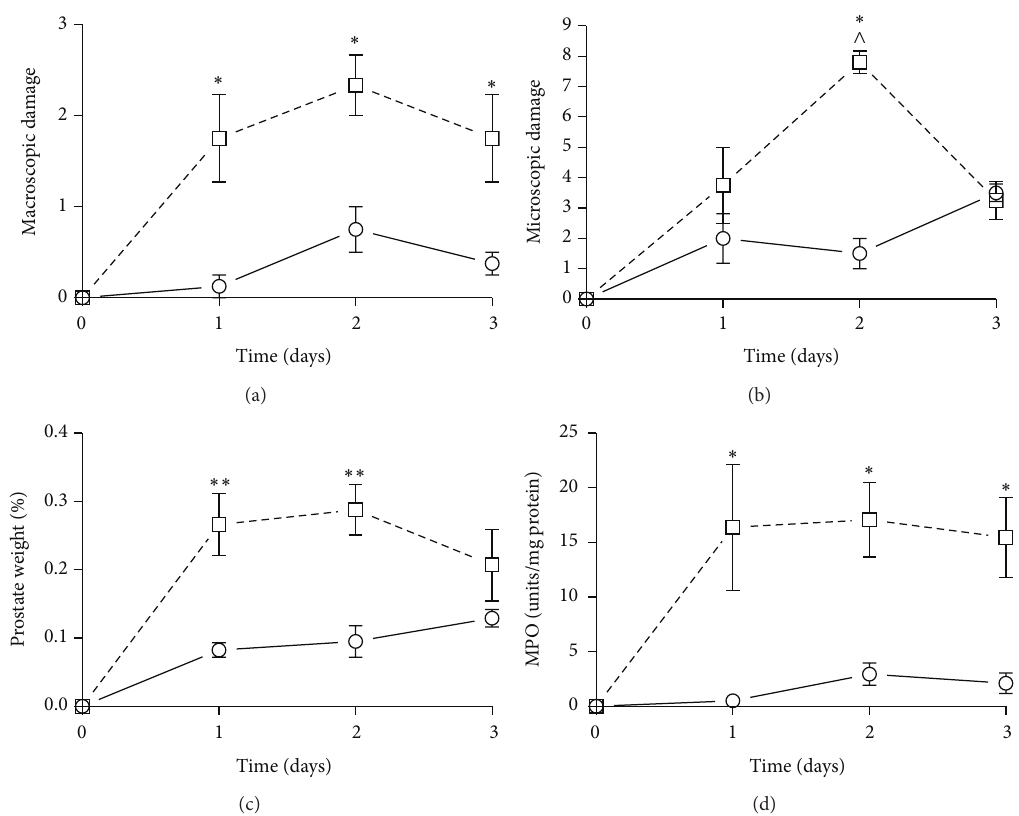
Figure 1: Ethanol + dinitrobenzene sulfonic acid induces inflammatory changes in wild-type mice 2 days posttreatment. Prostates were treated with sterile saline (circles) or ethanol + dinitrobenzene sulfonic acid (squares) for 1, 2, or 3 days starting on day 0. The inflammatory response was measured by monitoring (a) macroscopic prostate damage, (b) microscopic prostate damage, (c) percent prostate weight, and (d) myeloperoxidase (MPO) activity. Data are mean ± SEM of 𝑛 = 4–6 per point. ∗ 𝑃 < 0.05 , ∗∗ 𝑃 < 0.01 for EtOH + DNBS versus saline; ∧ 𝑃 < 0.05 for 2-day EtOH + DNBS versus 3-day EtOH +